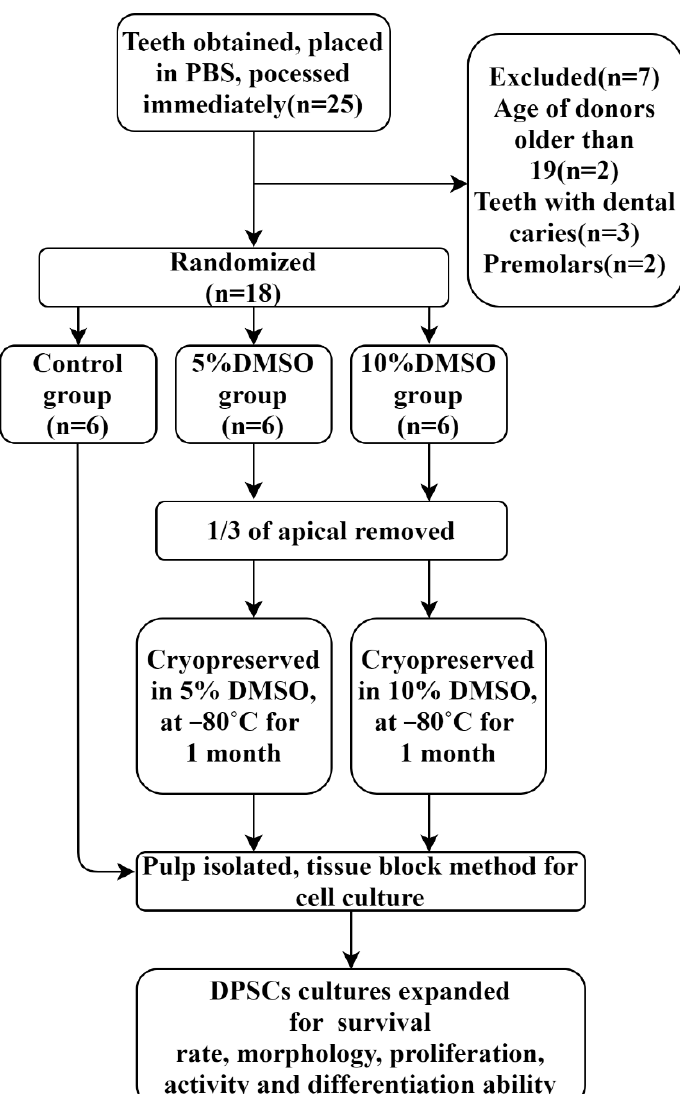
Figure 10. Flow diagram for teeth processing. DPSCs in six teeth were immediately cultured for cellular characterization experiments. After a month of cryopreservation, others were cultivated and examined.